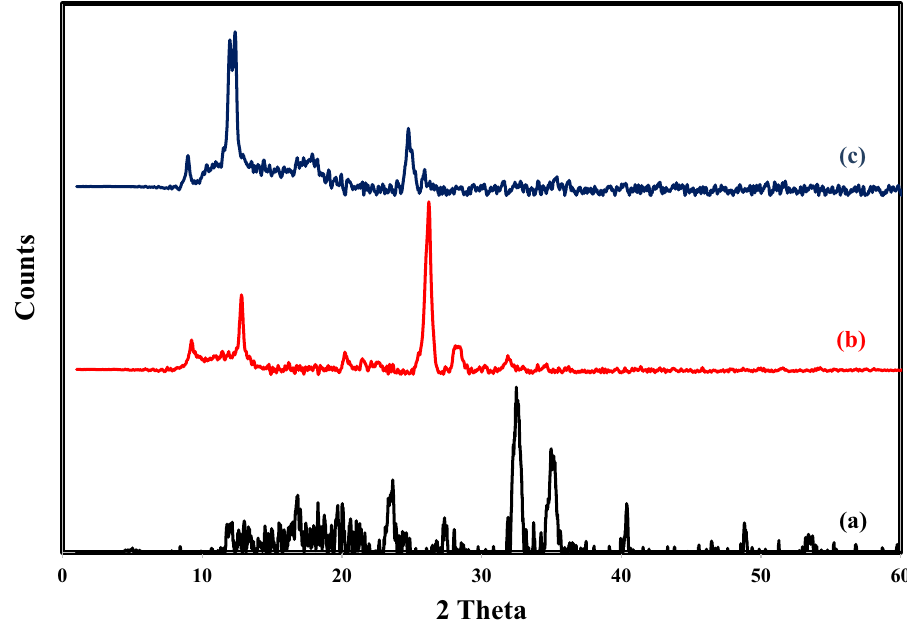
Figure 5. XRD patterns of ( a ) Fe 0.75 Cu 0.25 -BDC MOFs, ( b ) Alg-MoO 3 /GO and ( c ) Fe 0.75 Cu 0.25 -BDC@Alg- MoO